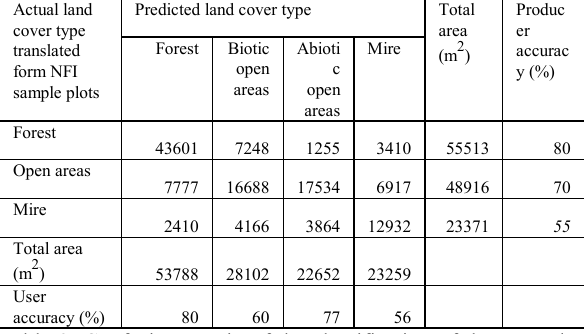
Table 2. Confusion matrix of the classification of the areas the CHM is computed using the national